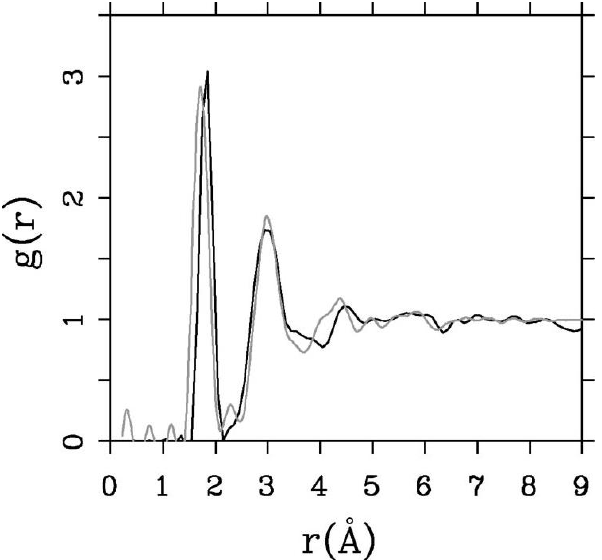
), properly weighted, 1.29